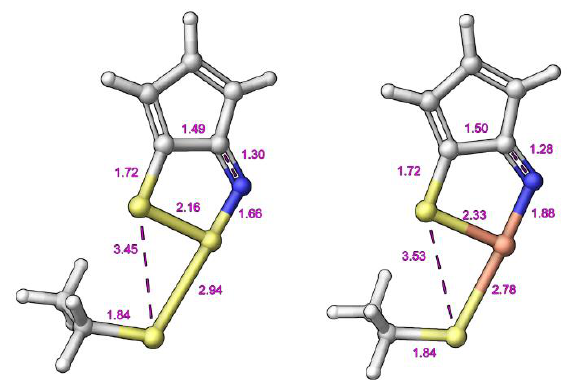
Figure 4. Transition state modelling of 1,2,3-dithiazole vs 1,2,3-thiaselenazole ring opening upon nucleophilic attack in model system. Numbers in purple show distance in Å . The selenium compound is missing the pseudo grids caused by convergence problems and cc-PVTZ(-F) basis set was used for transition states calculations in Jaguar.